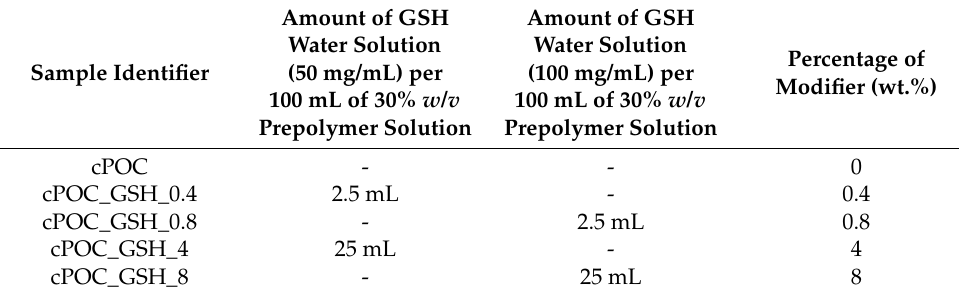
Table 1. Identifiers of the cross-linked polymers unmodified or modified with